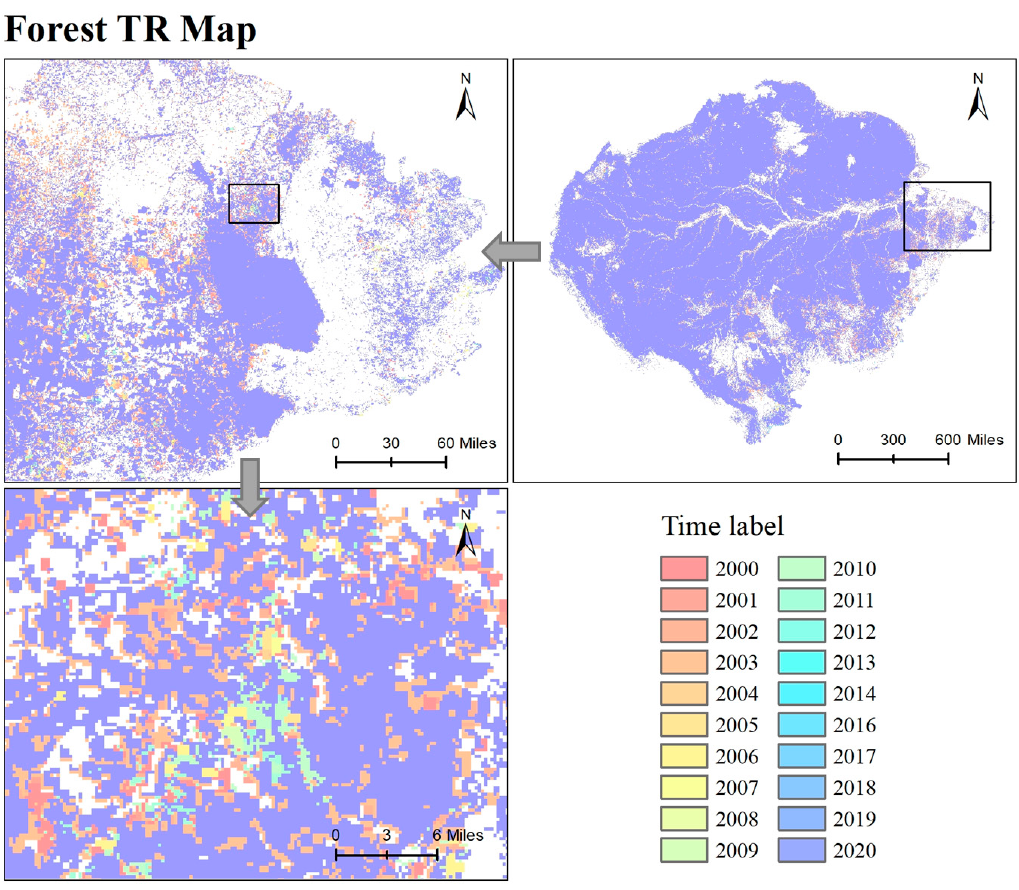
Figure 7. The forest time ring (TR) map from 2000 to 2020 in the Amazon basin.